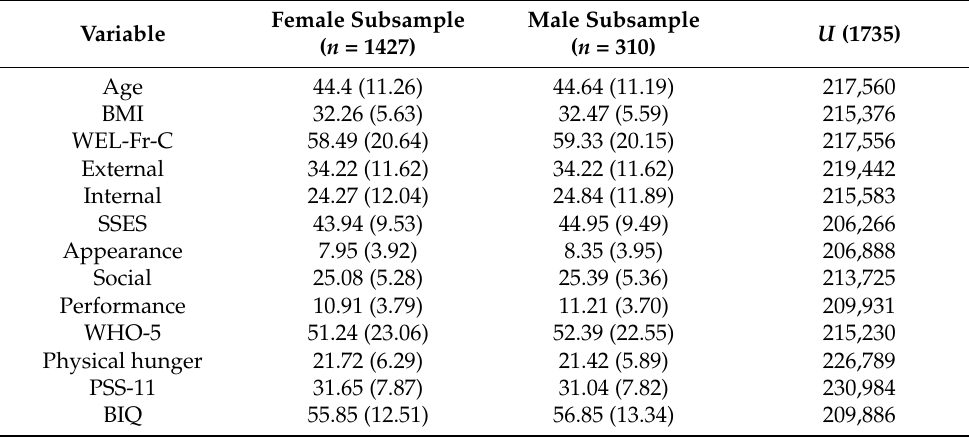
Table 2. Descriptive statistics and mean comparisons of the